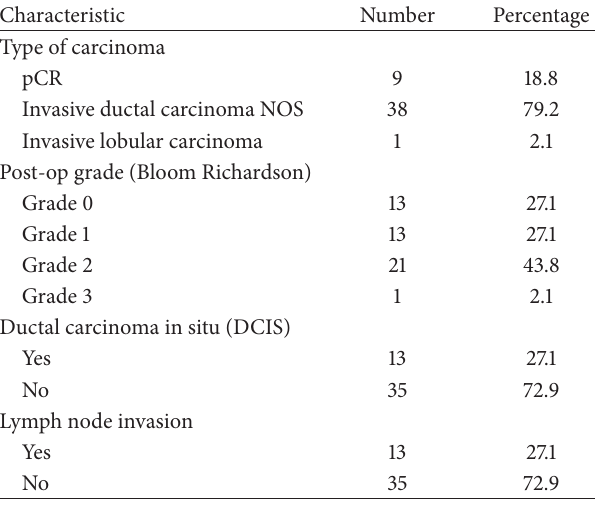
Table 4: Microscopic findings on examination of the resected specimen.